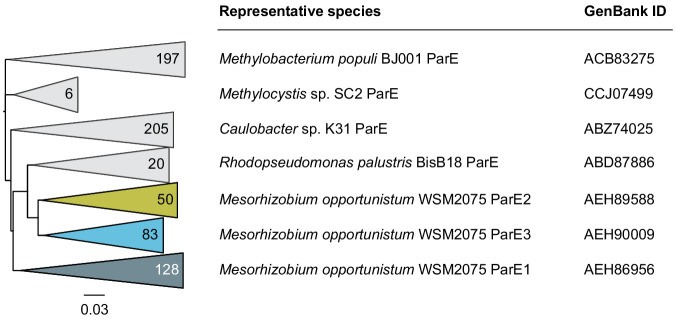
ParE protein tree.A representative protein from each clade is indicated.